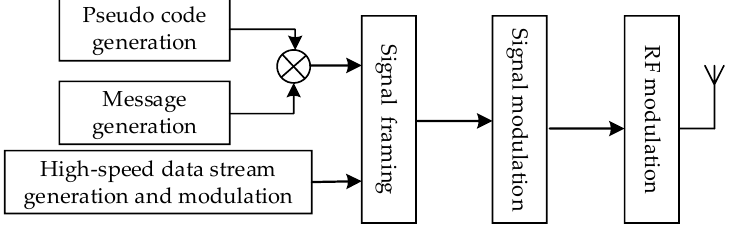
Figure 2. Flowchart of the signal generation.